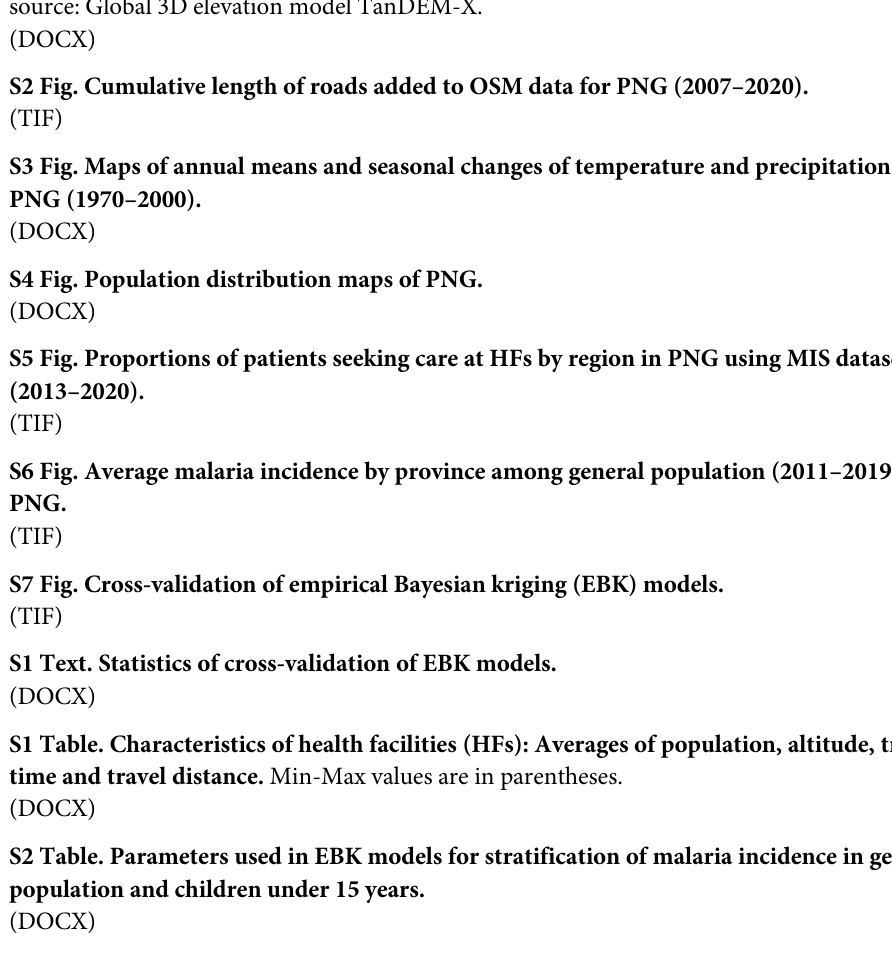
S1 Table. Characteristics of health facilities (HFs): Averages of population, altitude, travel time and travel distance. Min-Max values are in parentheses. S2 Table. Parameters used in EBK models for stratification of malaria incidence in general population and children under 15